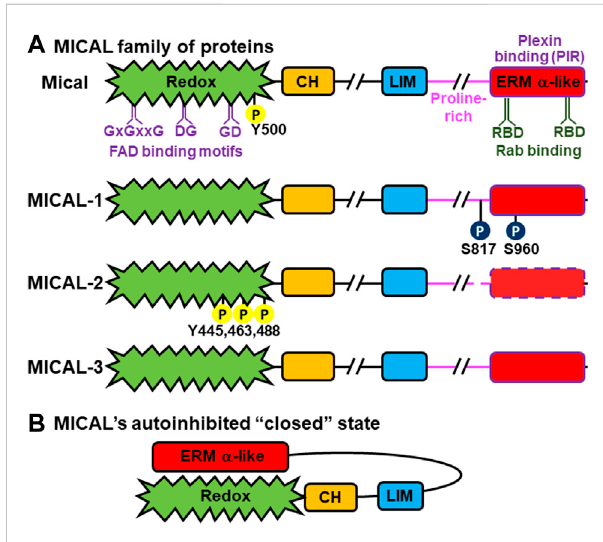
MICAL family proteins: domain organization and allosteric interaction. (A) Domain organization of Drosophila Mical and human/ mammalian MICAL-1, MICAL-2, and MICAL-3. All MICALs contain the N-terminal fl avoprotein monooxygenase (Redox) domain (green),followedbyacalponinhomology(CH)domain(orange),aLIM domain (blue), a proline-rich region (pink), and an ERM alpha ( α )-like domain (red). These domains are linked by regions of variable length (//). The FAD binding (GxxGxxG, DG, and GD) motifs in the Redox domain are denoted in purple. The two Rab binding (RBD) regions (dark green) and plexin binding (PIR) region (purple) within the ERM α - like domain are also shown. Sites of phosphorylation by Abl kinase are shown as yellow circles [Y (tyrosine)], while those of PAK1 kinase are in dark blue circles [S (Serine)]. It is notable that many annotated cDNAs for MICAL-2 do not contain the C-terminal ERM α -like region, but the MICAL-2 genomiclocusincludesanERM α -likeregionthatissimilarto MICAL-1 and MICAL-3. This region has independently been called MICAL-CL and Ebitein and is denoted here with dashed lines. (B) Full- length MICAL family members have been found to exist in autoinhibited (inactive) forms. In the autoinhibited form, the C-terminus ERM α -like domain of the MICAL ’ s folds in antiparallel fashion towards theN-terminus, andinteracts with theRedox and LIM domains to inhibit the Redox enzymatic activity of the